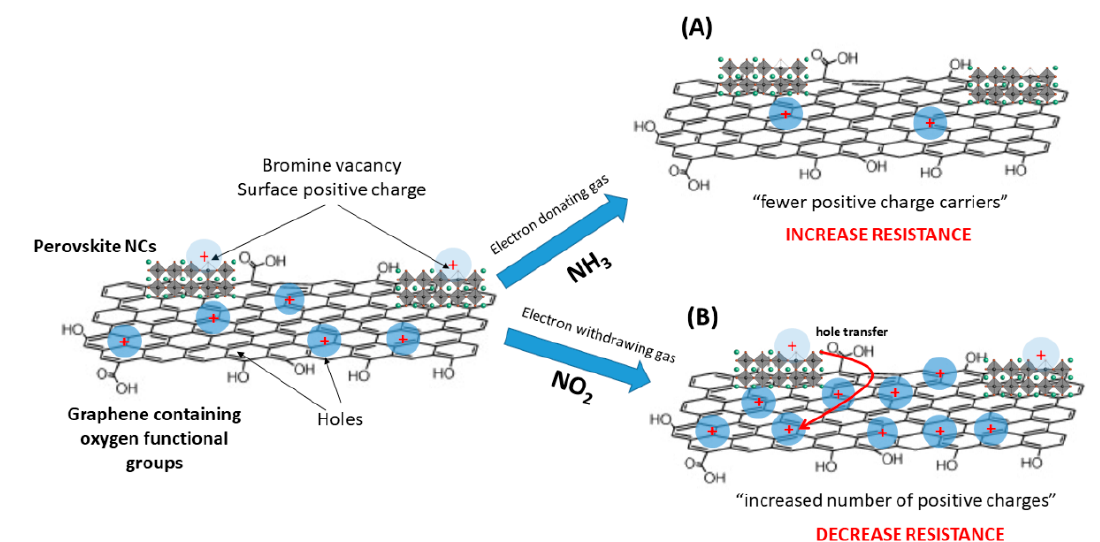
Figure 6. Synoptic illustration of the sensing mechanisms for graphene loaded with perovskite nanocrystals. ( A ) When halides perovskites interact with electron-donor gas, an excess of positive charges is neutralized at the defective perovskite surface, resulting in a decrease of the local hole concentration of the p-type graphene, and thereby the resistance increases. ( B ) When halide perovskites interact with electron-acceptor gas, positive charges are formed at the nanocrystals, being transferred to the graphene. As a result, the resistance decreases. Reproduced from Sensors MDPI 2019, 19 (20), 4563 .